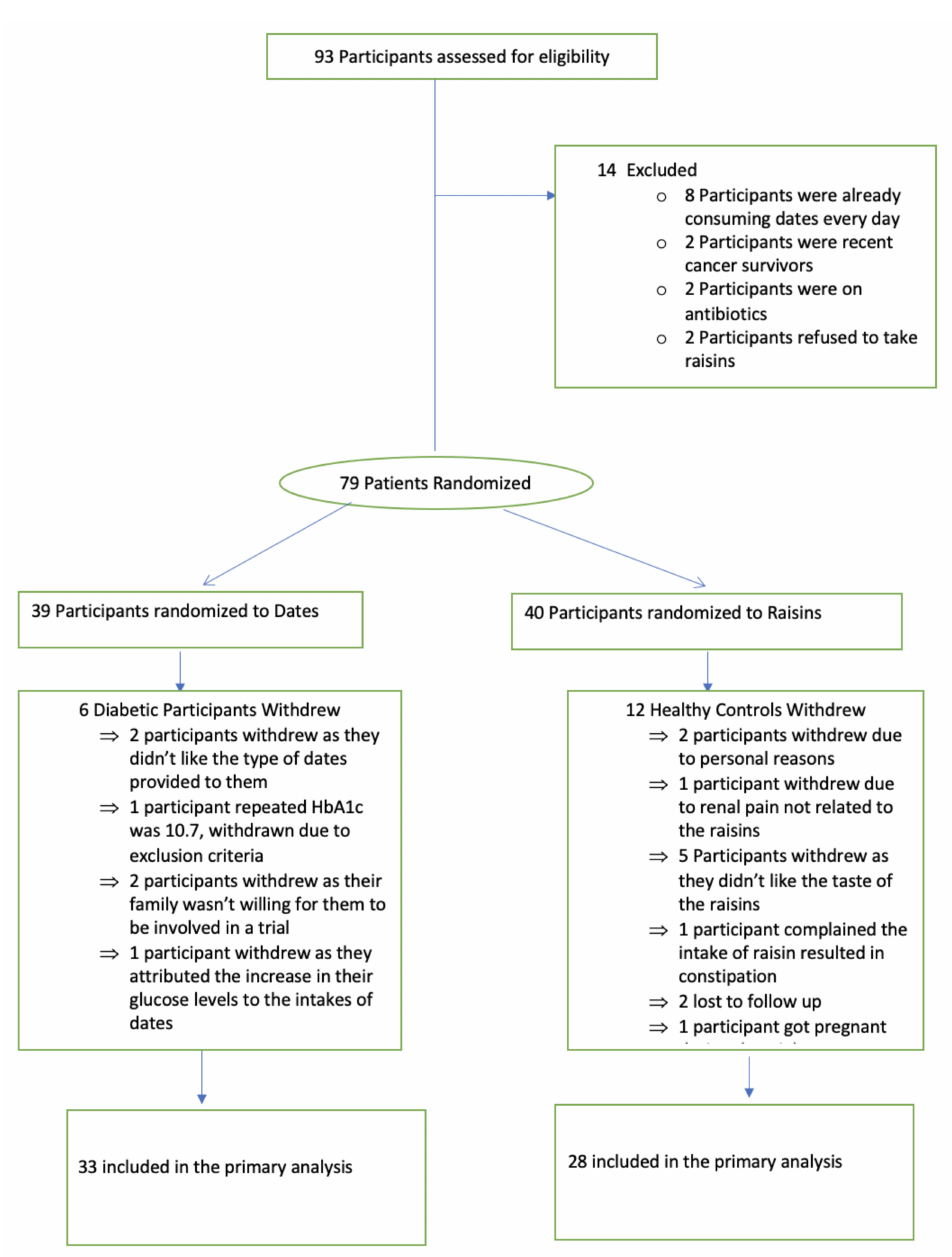
Figure 1. Flow diagram of the study